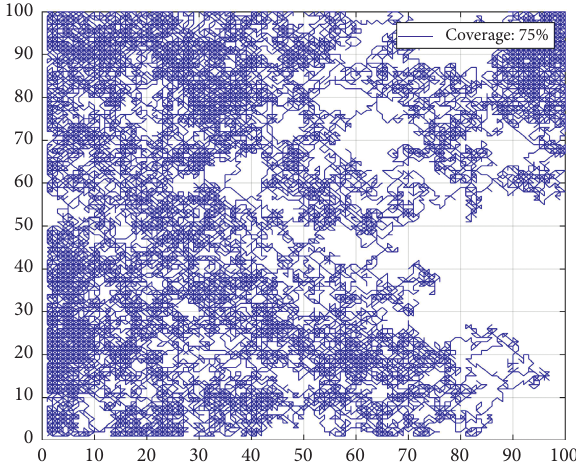
Figure 13: Grid coverage for 35,000 steps.